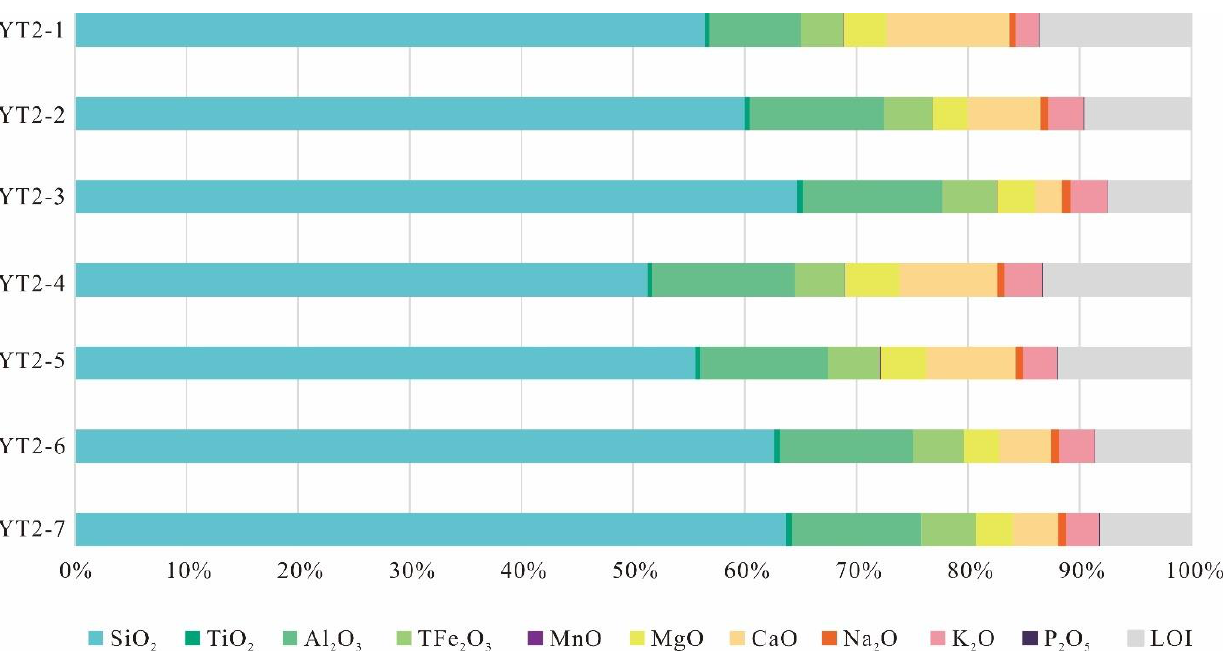
Figure 6. Diagram of major elements content.